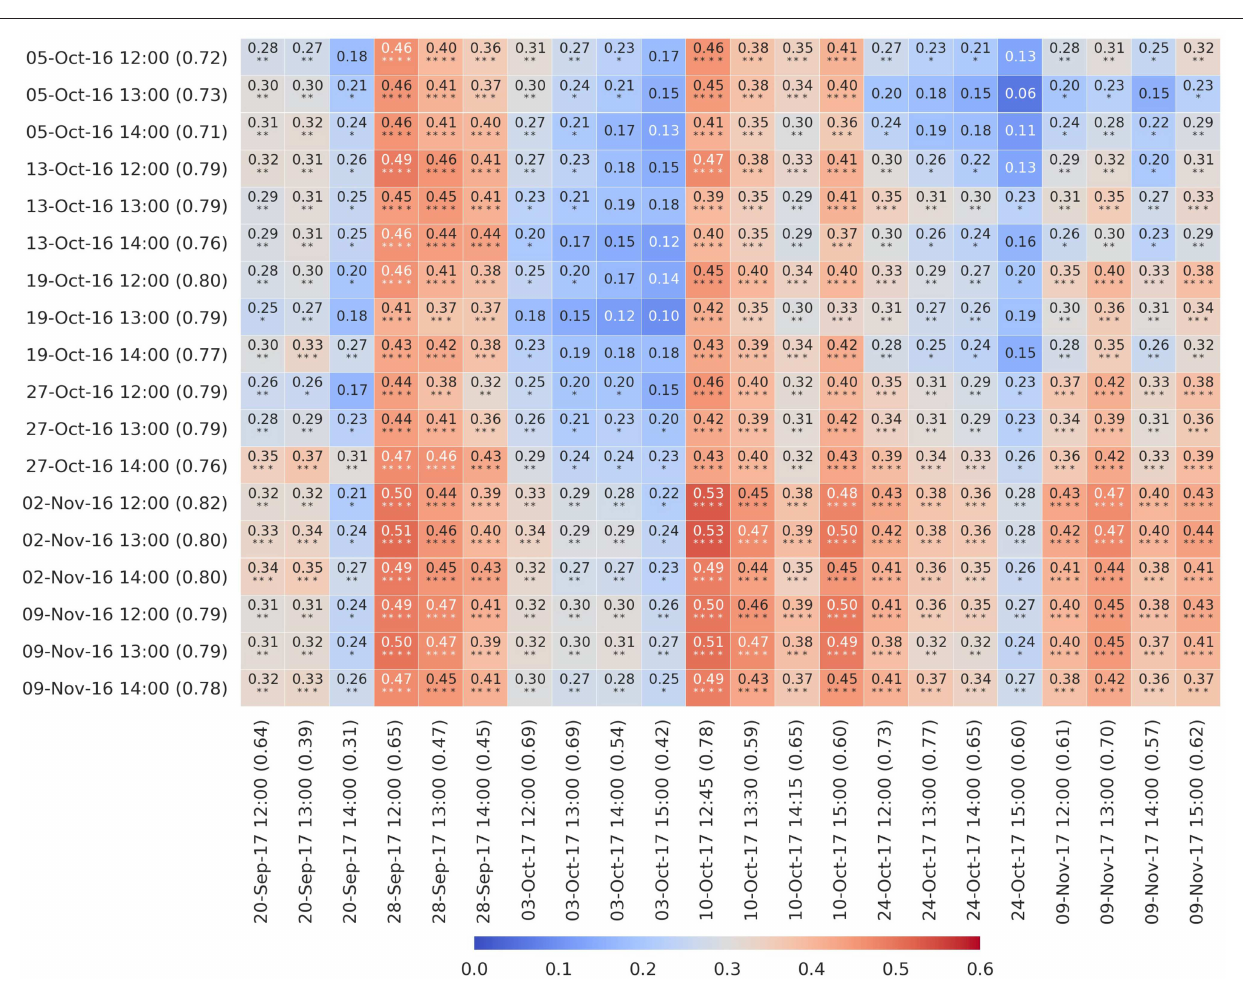
FIGURE 8 | Heatmap of phenotypic correlations between the best linear unbiased predictors of genotype effects (BLUPs) (98 genotypes) for selected airborne canopy temperature (CT) events in 2016 and 2017 (as shown in Figure 7 ). For 2016, on each day after (and including) 12:00. For 2017, for events on days after and including 20-Sept-17 and after 12:00. Repeatability is shown in parenthesis for each respective airborne CT event. The two days in 2017 where the correlations were greatest (28-Sept-17 and 10-Oct-17), occurred soon after irrigation or rain (24 mm irrigation on 22-Sept-17 and 8 mm rain on 9-Oct-17) when the crop was less